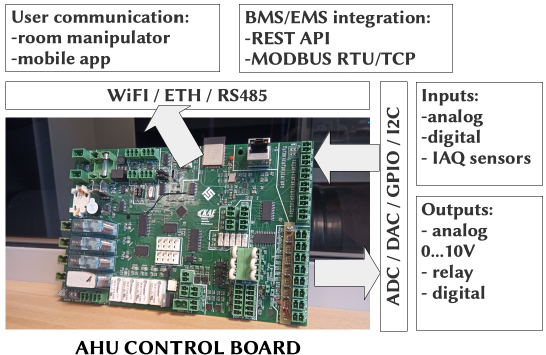
Figure 7. View of the developed control board with implemented discussed